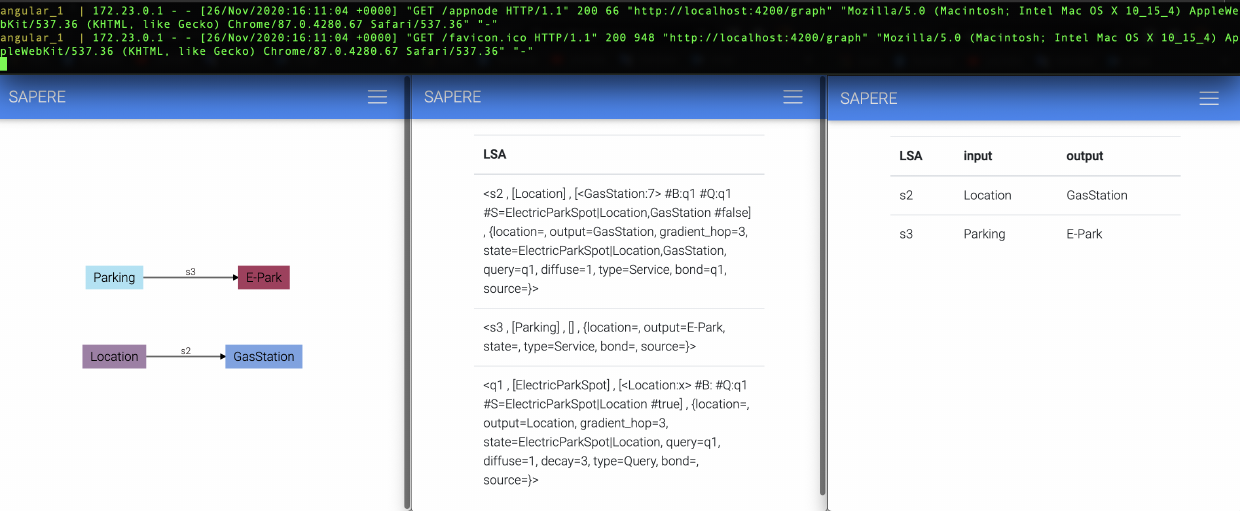
Figure 12. The experiment of the electric car parking scenario using the syntactic